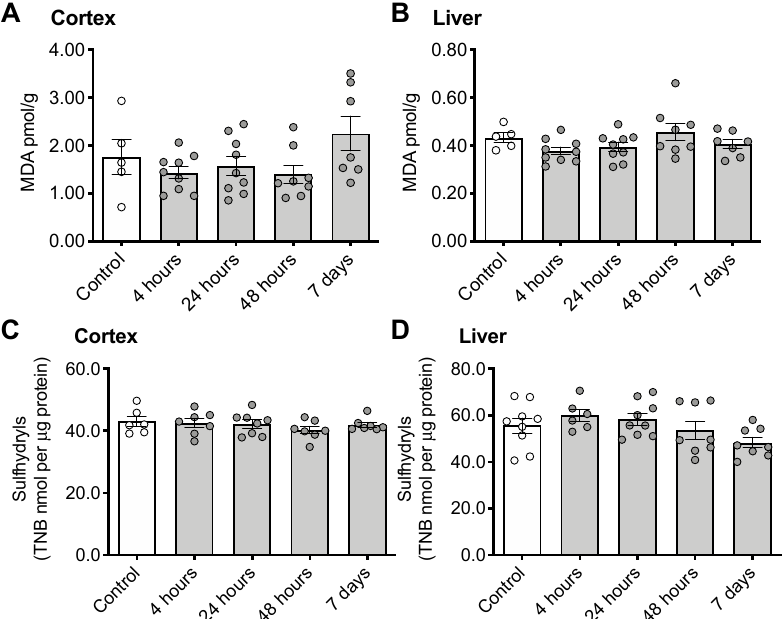
Figure 3. Indicators of oxidative stress following CS treatment. Malondialdehyde (MDA) in cortex ( A ) and liver ( B ) or sulfhydryls in cortex ( C ) and liver ( D ). Error bars plotted as mean ± SEM.